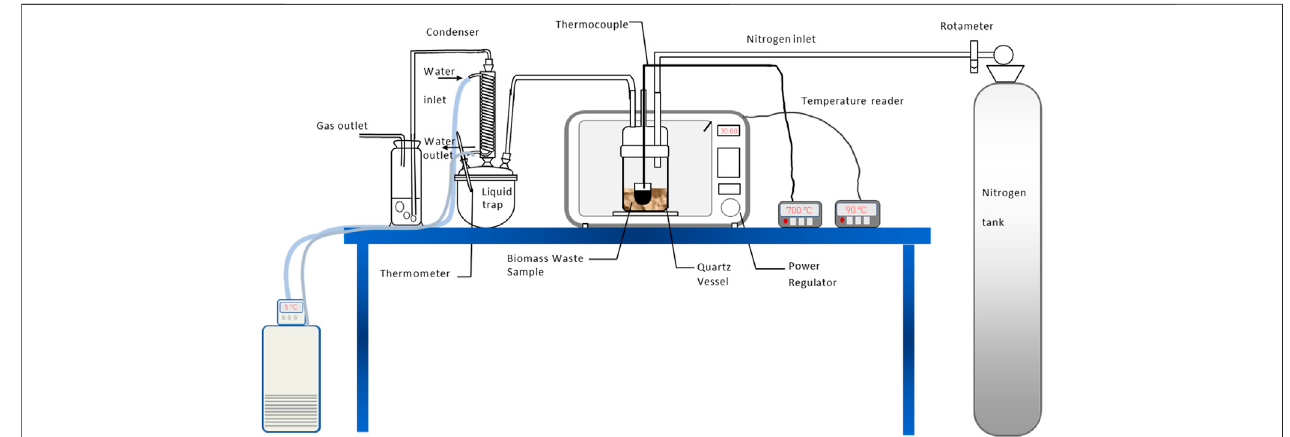
FIGURE 1 | Schematic diagram of microwave irradiation pyrolysis system.